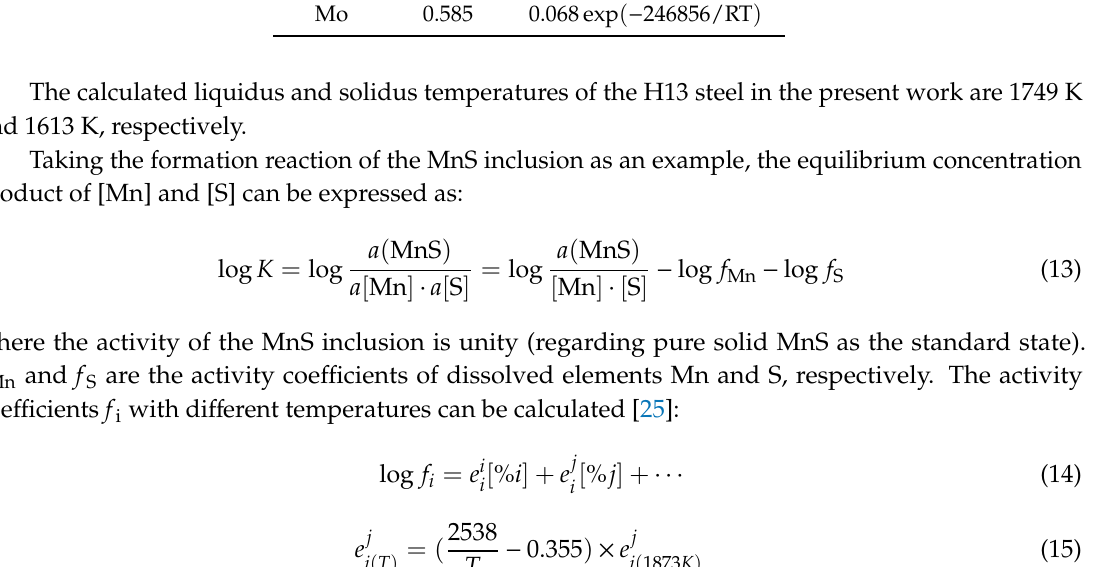
Figure 9 indicates the variation of the element concentration product with the solid